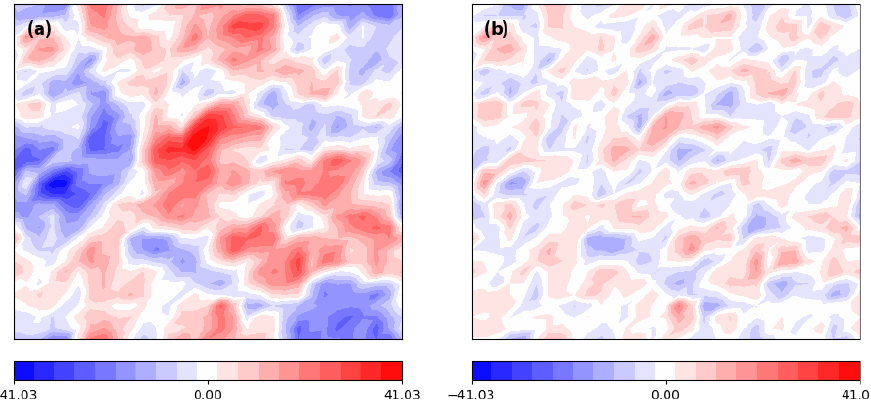
Figure 7. (a) A realization of the prior density of C for the γ 50 experiment. (b) A realization of the posterior density of C for the γ 50 experiment with mean c MAP